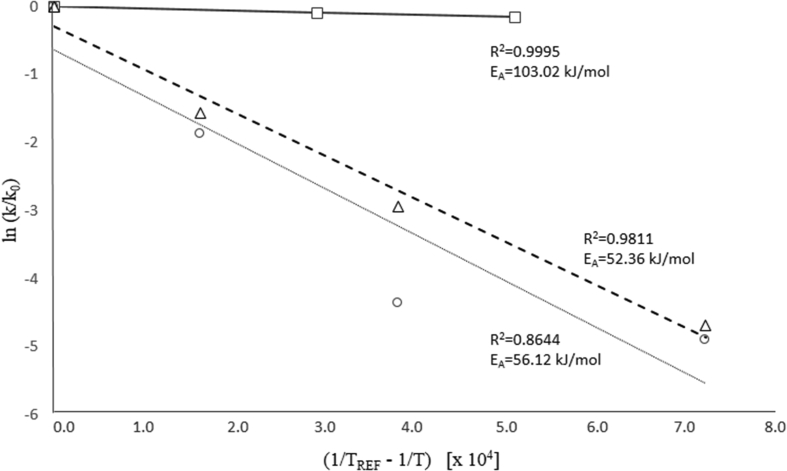
Arrhenius parameters for estimating the kinetic constants from the experimental data of Fahey et al. (2017). Free sulforaphane (○); Free sulforaphane in α-cyclodextrin solution (Δ); Sulforaphane microencapsulated in α-cyclodextrin (□).